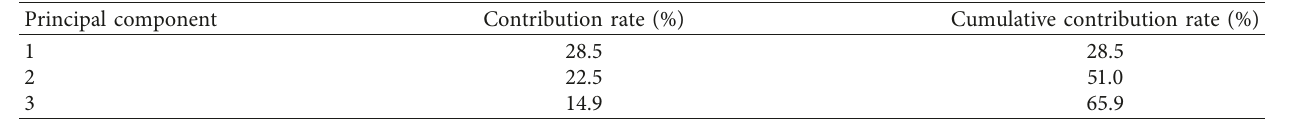
Table 5: Contribution and cumulative contribution of principal